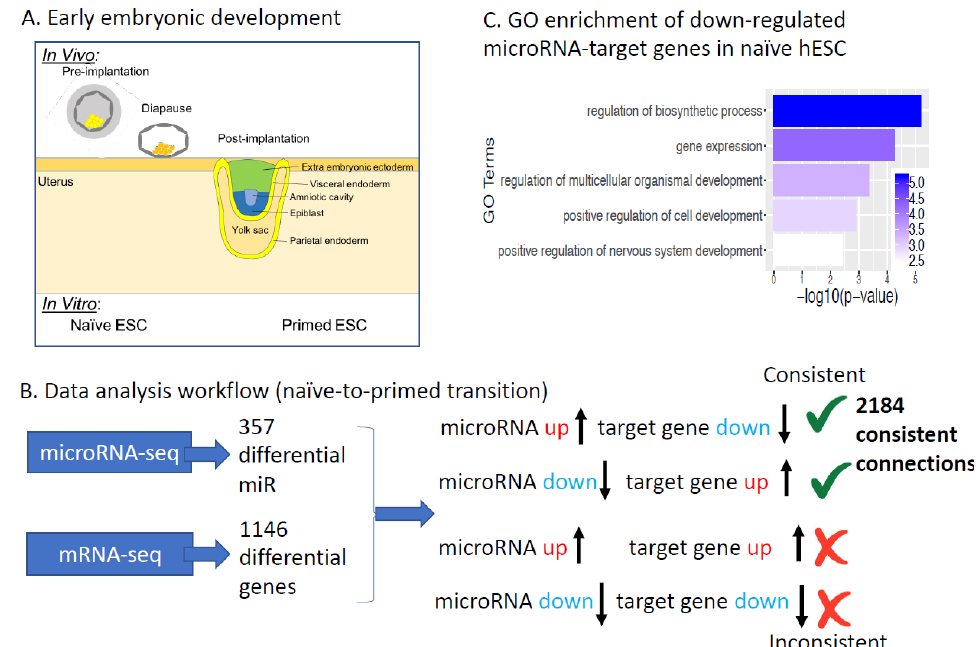
Figure 1. microRNAs regulating human naïve to primed ESCs transition: ( A ) A schematic figure of early embryonic developmental stages. ( B ) Analysis workflow. We first identified 357 differentially expressed microRNAs and 1146 differentially expressed protein-coding genes in two naïve-primed studies [27,45]. We then used mirTarBase to connect changes in microRNA and their experimentally validated target genes, and filtered down to 2184 miR-target gene connections where microRNA is up and its target is down (or vice versa). Green √ means the microRNA-gene connection is considered consistent; red × means the connection is not consistent. ( C ) Gene ontology enrichment of microRNA target genes with lower expression in human naïve ESCs (the microRNA regulators are higher in naïve). x-axis is negative log10 of enrichment p -value (larger means more significant).